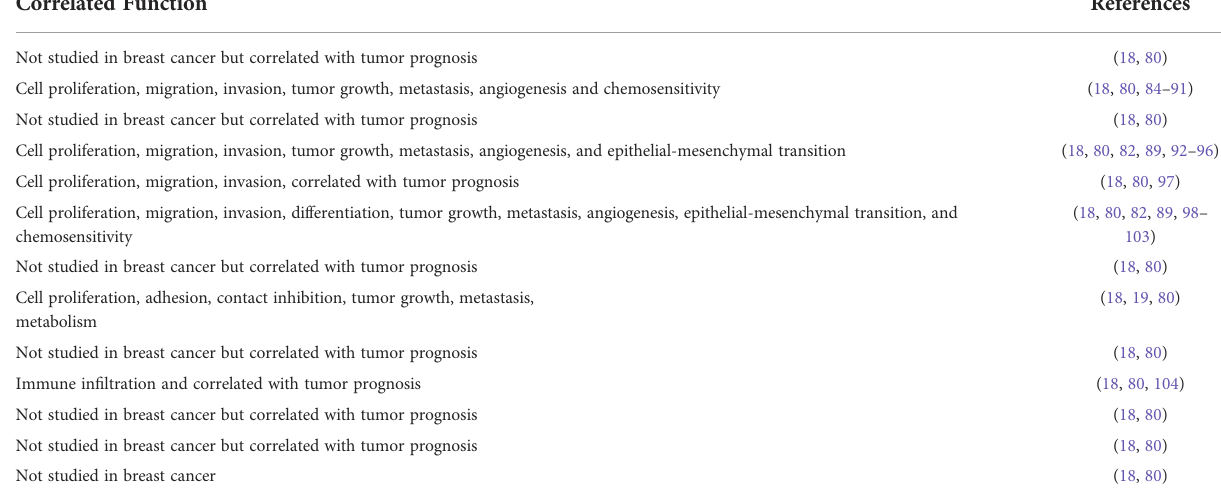
TABLE 1 Aquaporin Expression in Breast Cancer. AQP expression in breast cancer and their correlated functions. Correlated